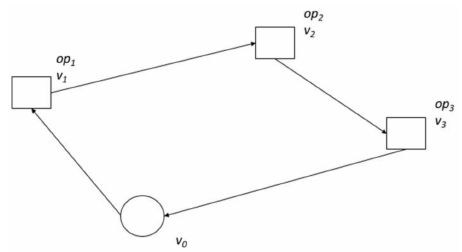
Figure 5. Improved